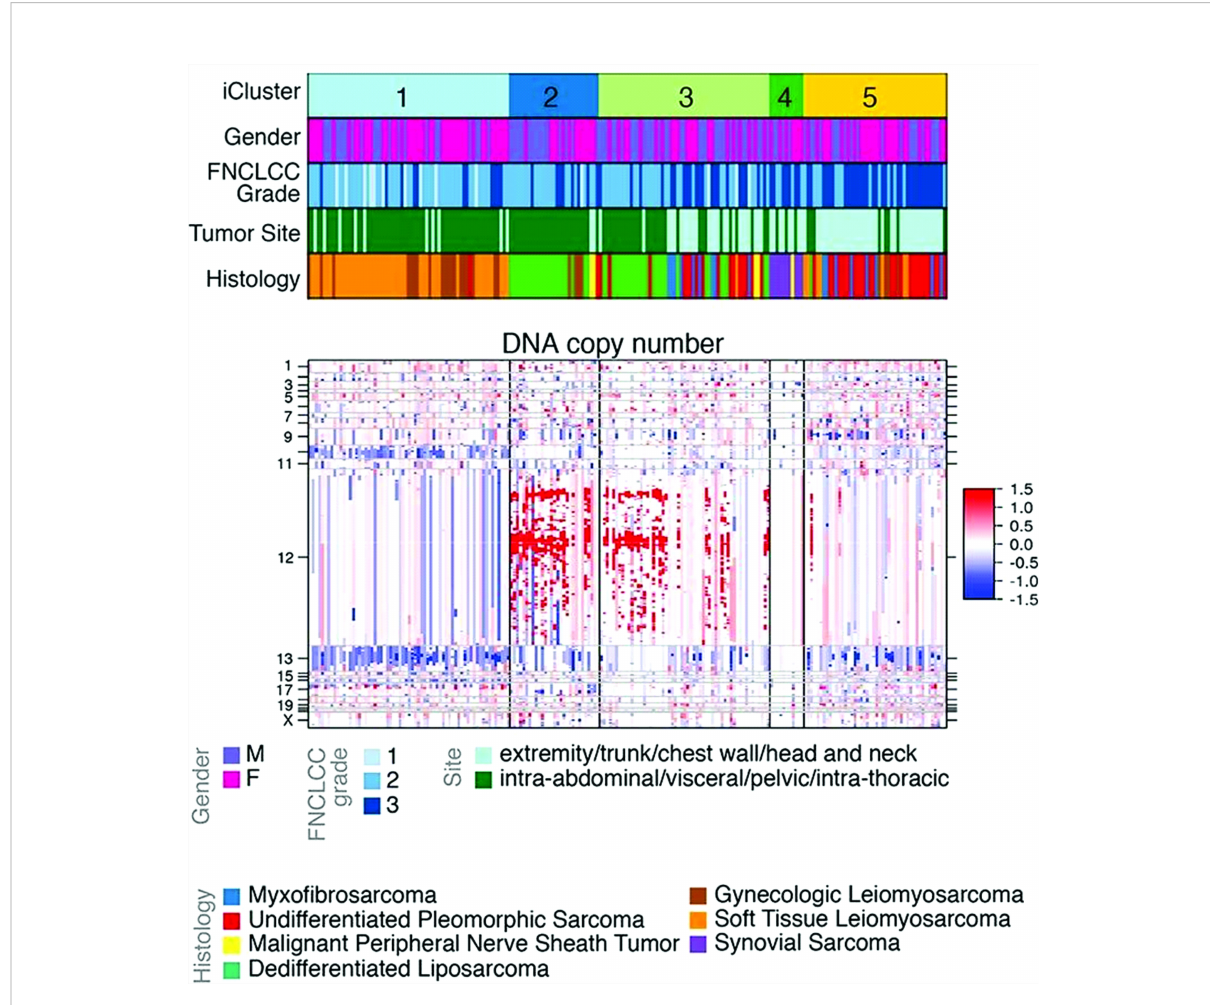
FIGURE 1 Clustered analysis of DNA copy number among soft-tissue sarcomas. Cluster C1 is primarily composed of leiomyosarcoma. Clusters C2 and C3 are primarily composed of dedifferentiated liposarcoma. Cluster C4 is composed of synovial sarcomas and malignant peripheral nerve sheath tumors. Cluster C5 is composed of high-grade undifferentiated pleomorphic sarcomas. Ampli fi cation in red, deletion in blue. Adapted from Comprehensive and Integrated Genomic Characterization of Adult Soft Tissue Sarcomas